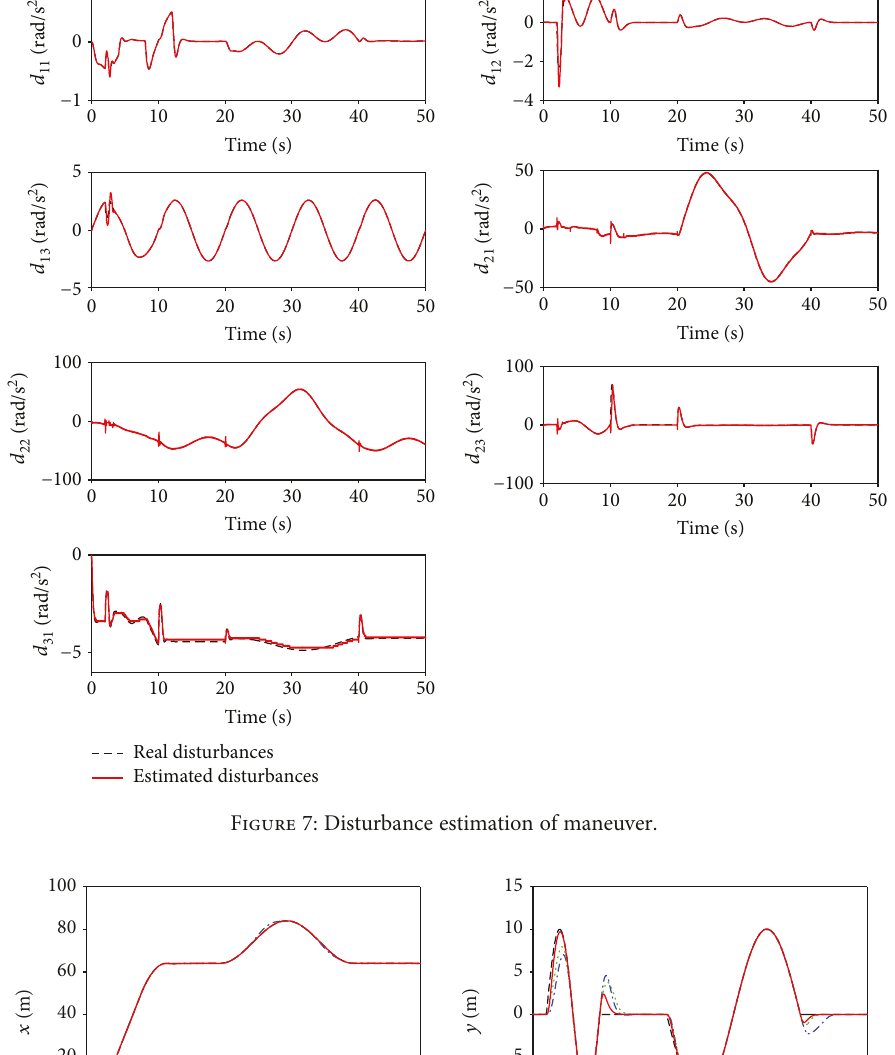
Figure 7: Disturbance estimation of maneuver.